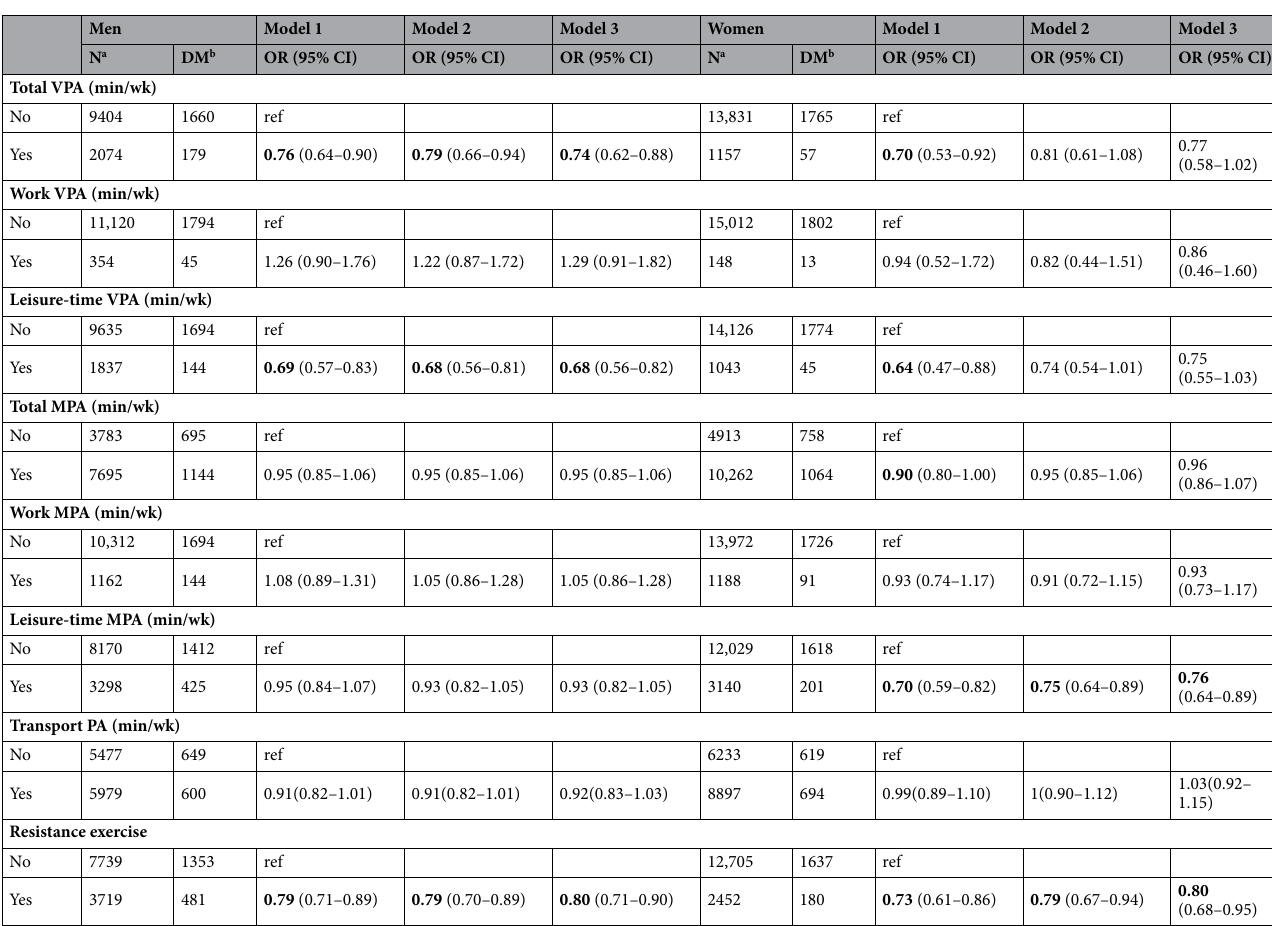
Table 3. Odds ratio (95% CI) according to domain-specific physical activity by intensity and type. Model 1: Adjusted for age, Model 2: Adjusted for Model1 + DM family history, alcohol consumption, smoking,